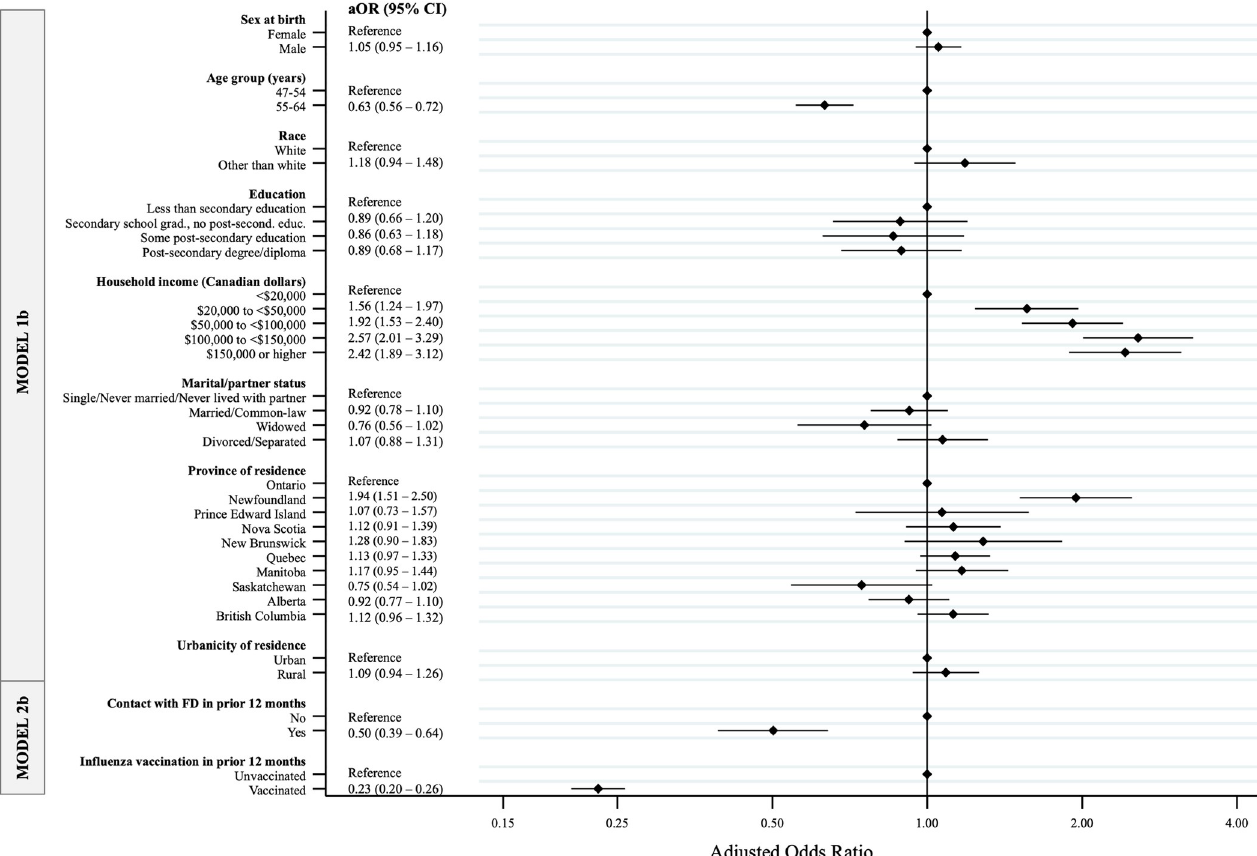
Fig 2. Factors associated with pneumococcal non-vaccination among CLSA participants aged 47–64 who reported having a chronic medical condition (CMC) and had complete data (n = 10,284). Adjusted odds ratios (ORs) and 95% confidence intervals (CIs), plotted on the log-odds ratio scale, were estimated through nested logistic regression models: Model 1 for sociodemographic characteristics; Model 2b for recent history of contact with a family doctor and recent influenza vaccination history, adjusting for socio-demographics.